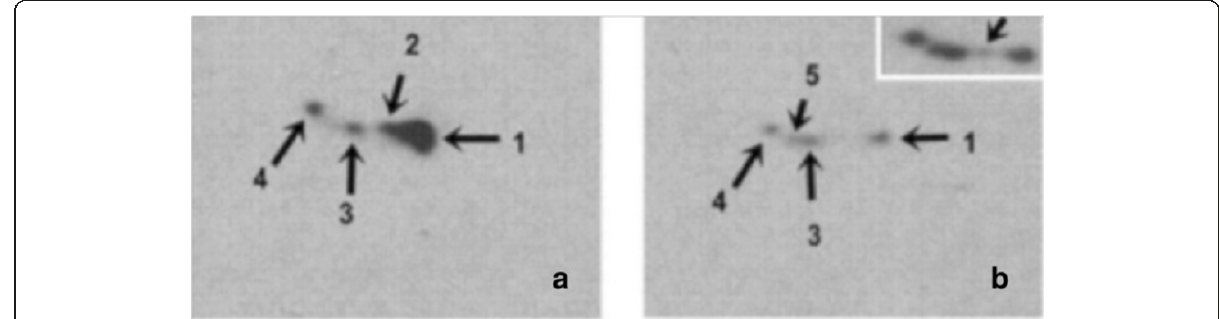
Figure 3 2-D Western blot analysis of normal and mutant axolotl hearts using CH1 monoclonal antibody. a . Stage-36 normal hearts show 4 different CH1-recognizable TM isoforms #1, #2, #3, and #4) . b . Mutant heart at stage-36 all show 4 CH1-recognizable TM isoforms as in normal hearts at much lower levels along with an extra isoform (#5). #5 isoform is detectable in normal hearts at later developmental stages (results not shown). The top right corner represents an overexposed blot B [12]. The figure was adapted from Zhang et al. [12].